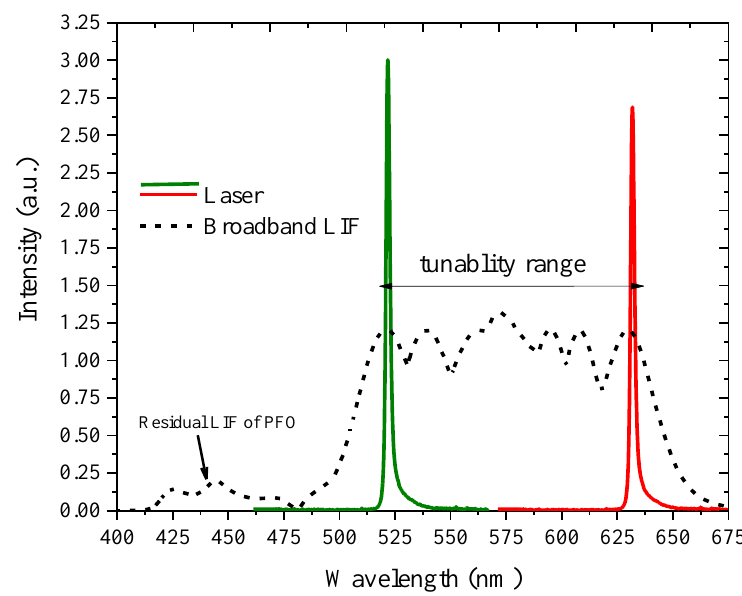
Figure 8. Narrow laser spectra and Laser Induced Fluorescence (LIF) of the solution.